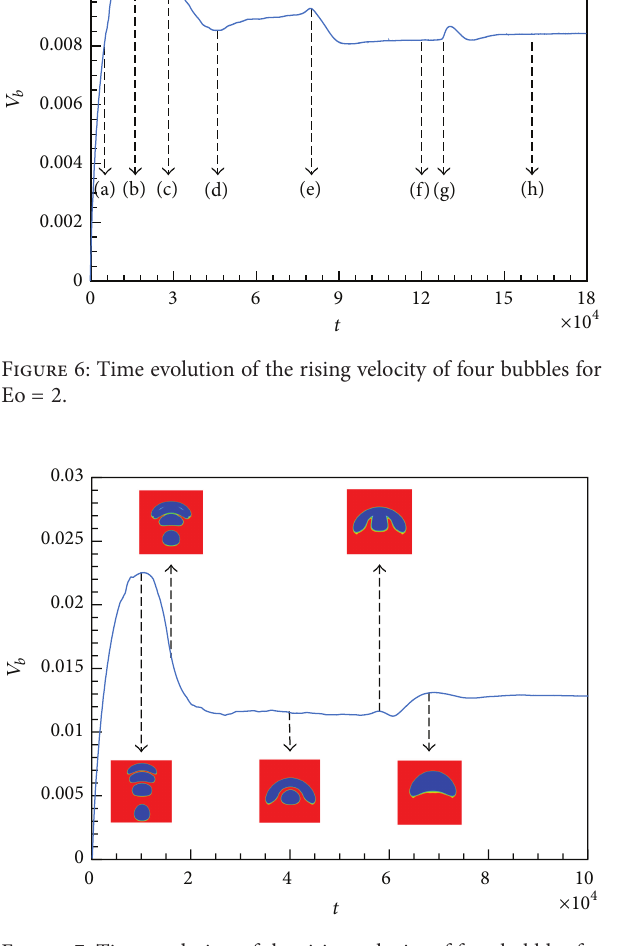
Figure 7: Time evolution of the rising velocity of four bubbles for Eo = 5 .